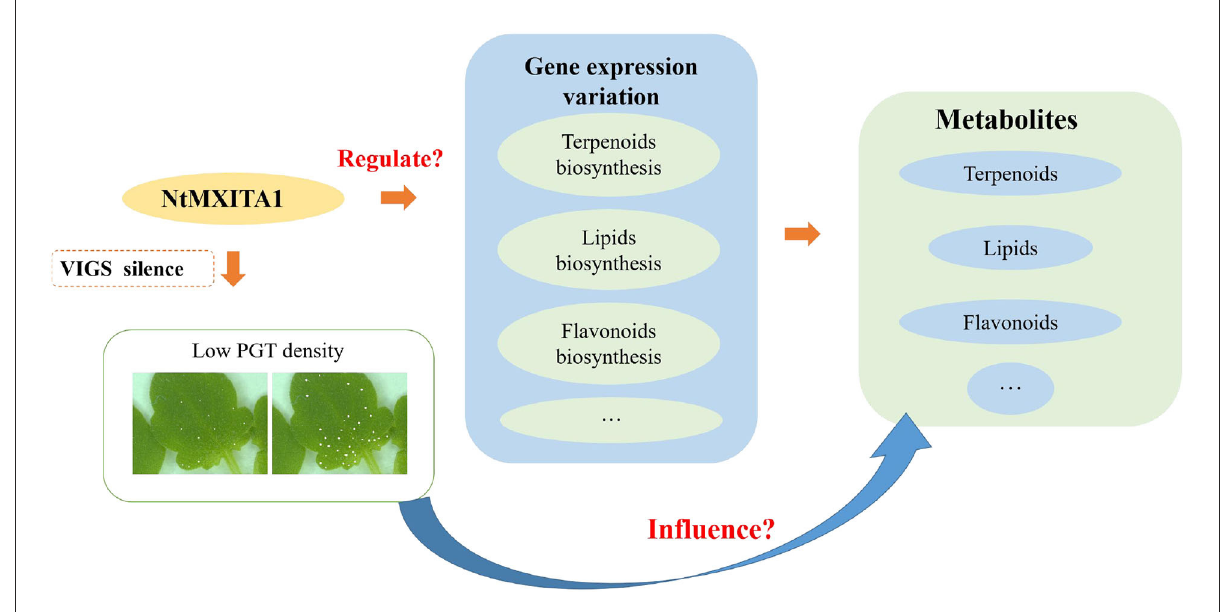
FIGURE7 Hypothesis model of N. tenuifolia PGT initiation and metabolite